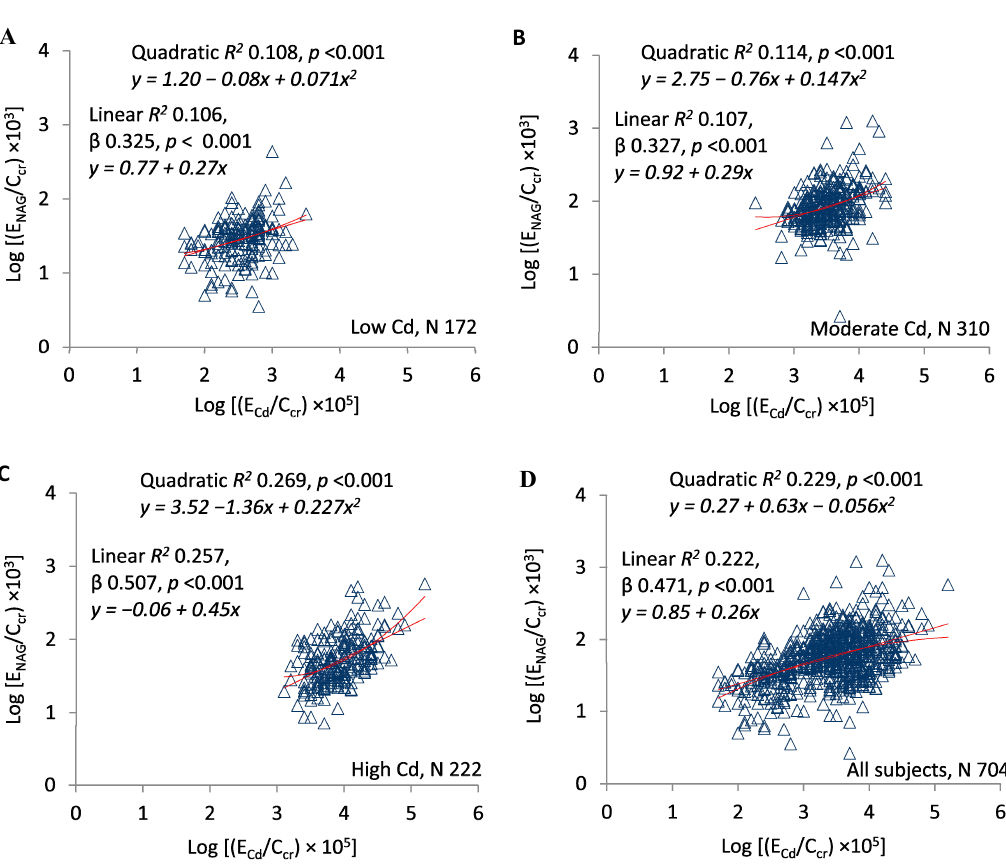
Figure 3. E Cd /C cr as a predictor of E NAG /C cr . Scatterplots compare log[(E NAG /C cr ) × 10 3 ] to log[(E Cd /C cr ) × 10 5 ] in subjects grouped by locality ( A – C ) and in all subjects ( D ). Quadratic and linear coefficients of